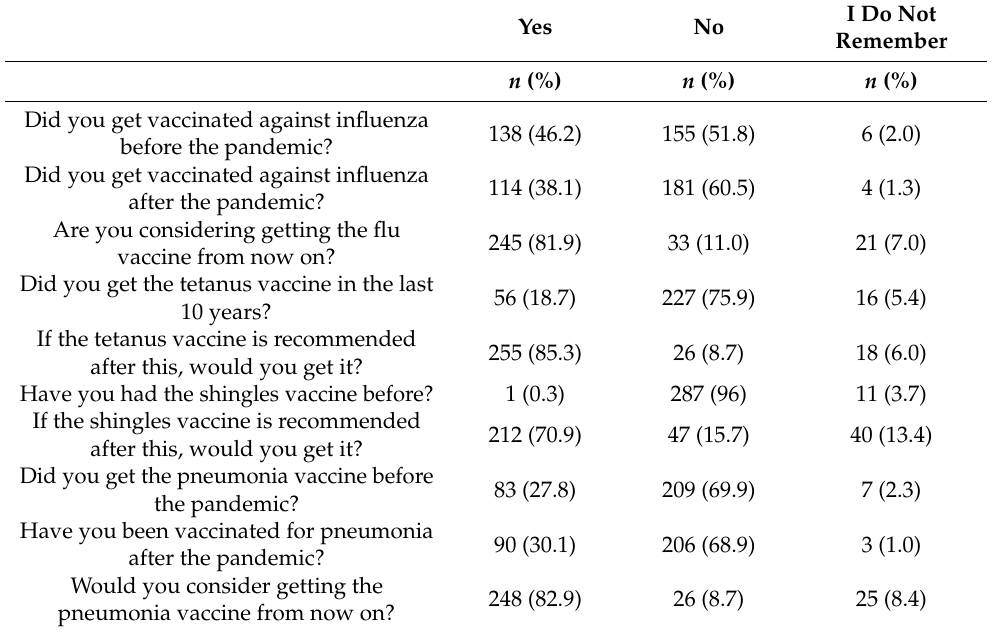
Table 3. Vaccination attitudes of the participants before and after the pandemic.